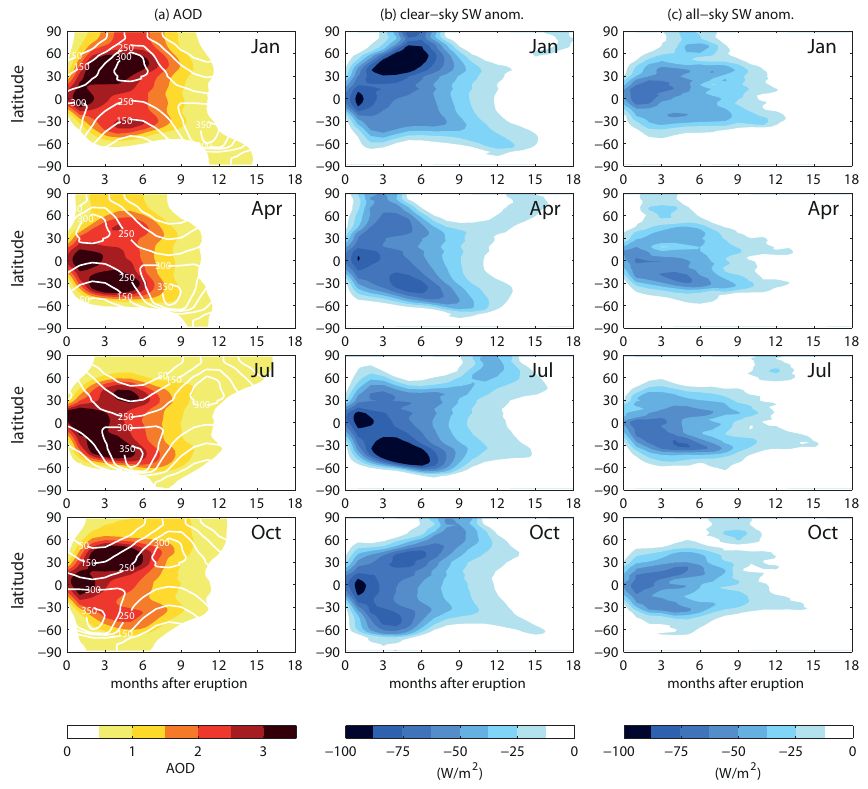
Fig. 8. As Fig. 3, for the E700